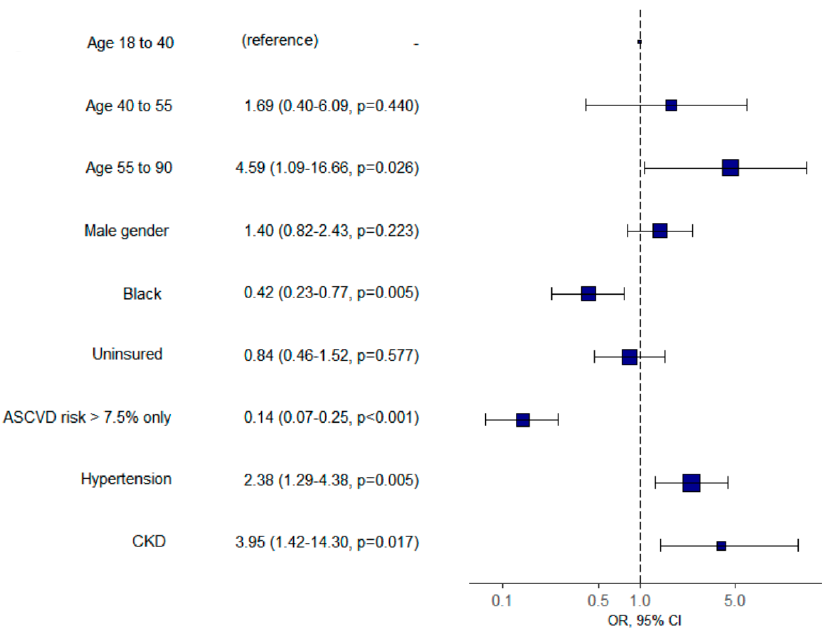
Figure 3. Adjusted odds of statin prescribing by age (reference age 18–40 years old) for various comorbidities (95% CI, p -value).